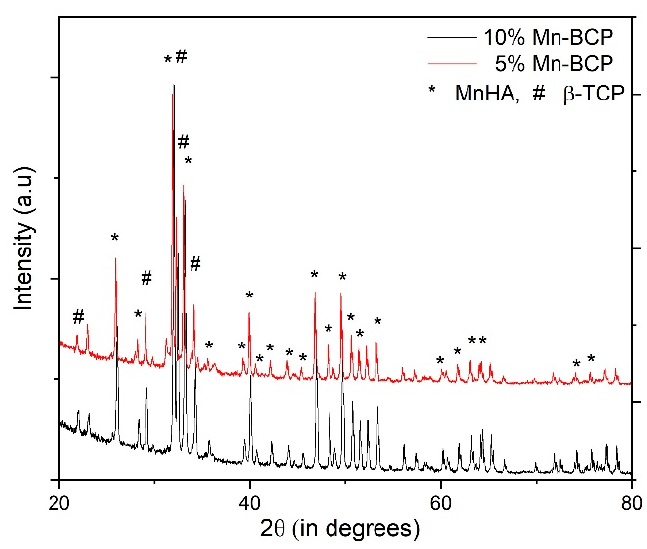
Figure 1. XRD pattern of manganese-doped biphasic calcium phosphate scaffolds.